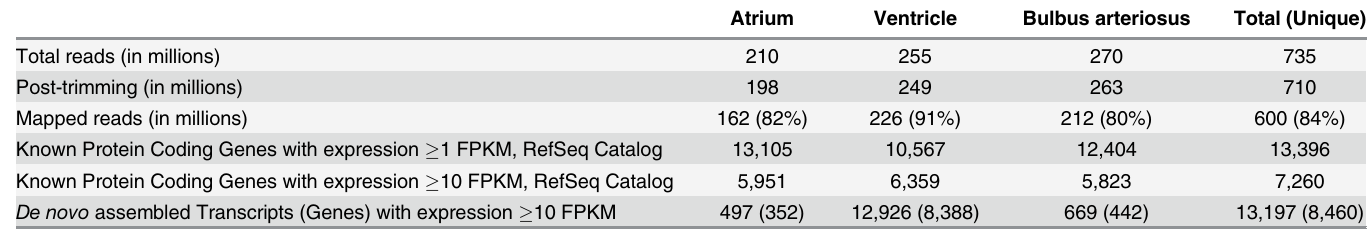
Table 1. Summary of the RNA sequencing data generation and alignment. Total number of sequence reads obtained from the three cardiac chambers using RNA sequencing is described. Mapped reads refer to and include all transcripts that aligned back to the zebrafish reference genome (Zv9). The total number of uniquely expressing known protein coding genes as well as de novo transcripts are